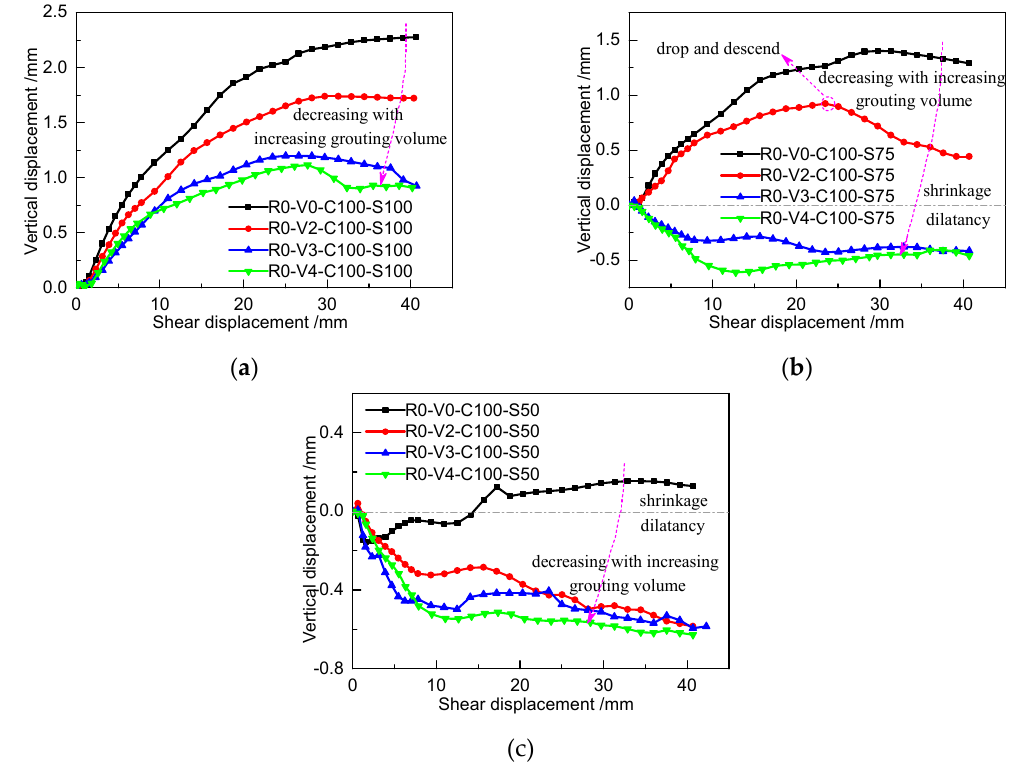
Figure 13. Dilation/shrinkage varying with increasing grouting volume for specimens with R0 in Figure 13. Dilation / shrinkage varying with increasing grouting volume for specimens with R0 in